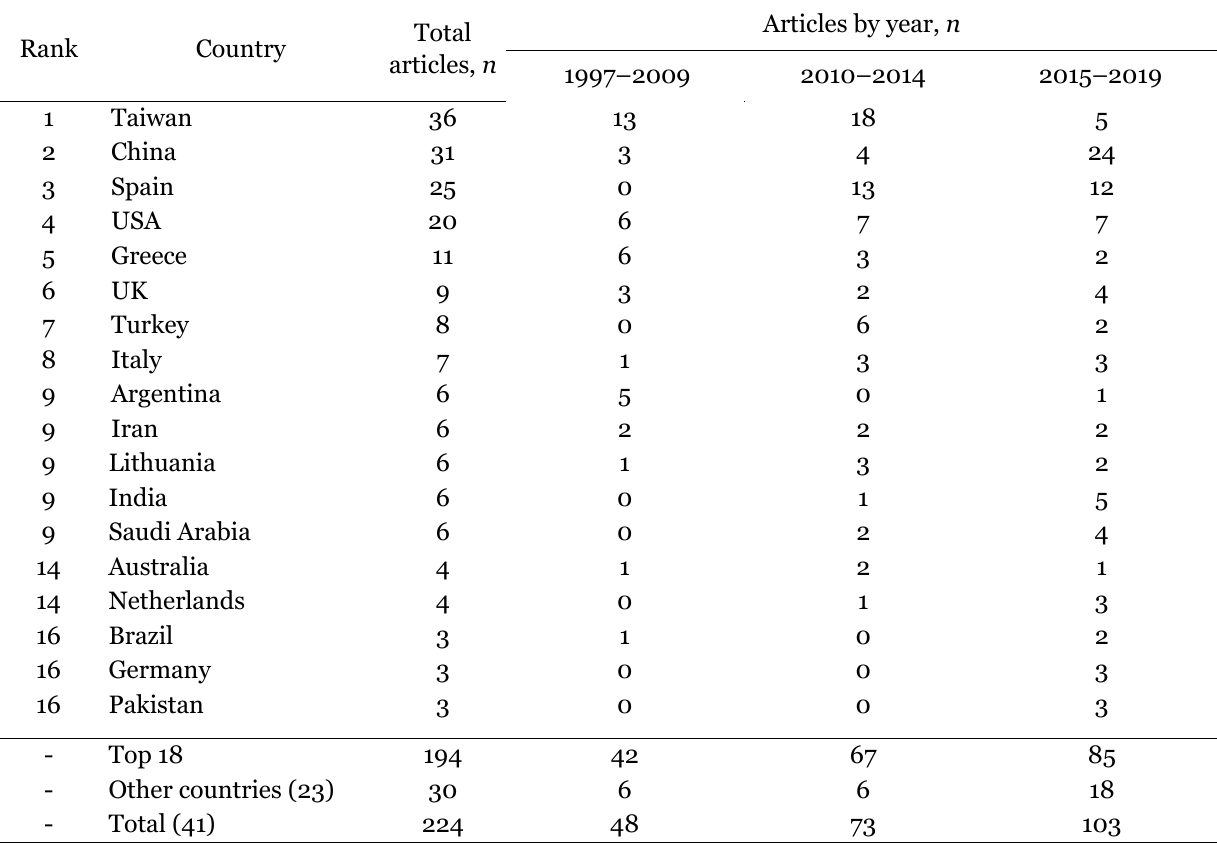
Table 2 Number of Articles and Rankings of the Most Productive Countries of the AI-Related Publications in the Context of Online Learning